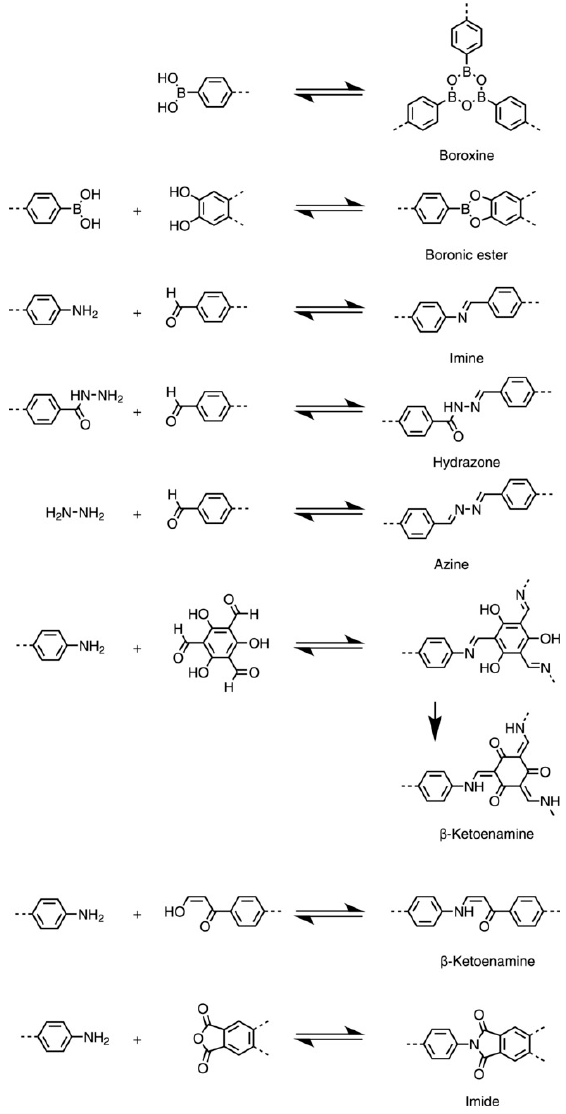
Figure 2. Widely applied condensation reactions for the formation of COFs. Reprinted from [10] with permission of Wiley.